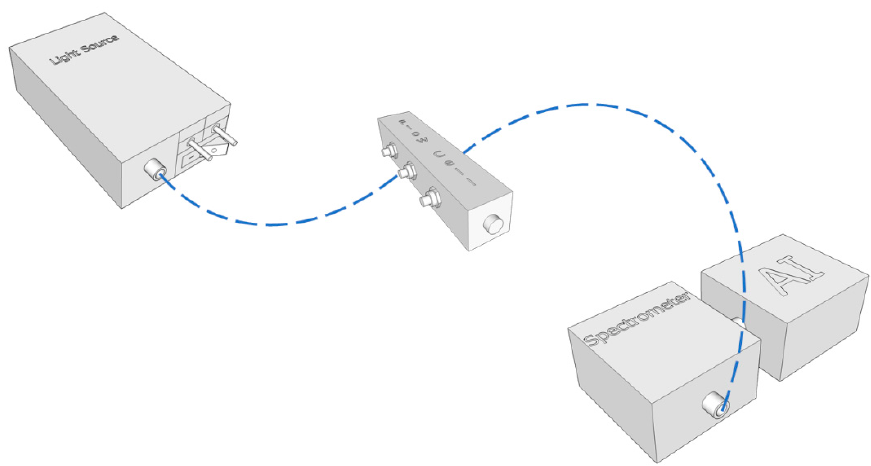
Figure 1. Schematics of the components of a compact, portable and low-cost prototype system.